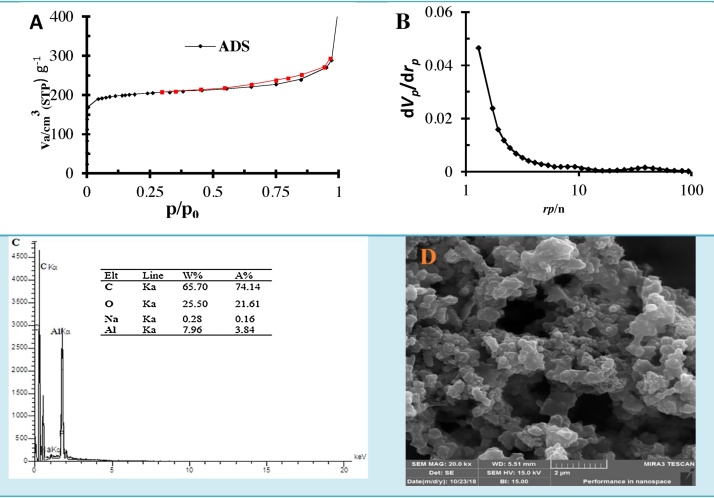
Elemental analysis and morphology of C/Al2O3: (A) Nitrogen adsorption-desorption isotherms, (B) Pore size distribution, (C) EDAX, (D) SEM.